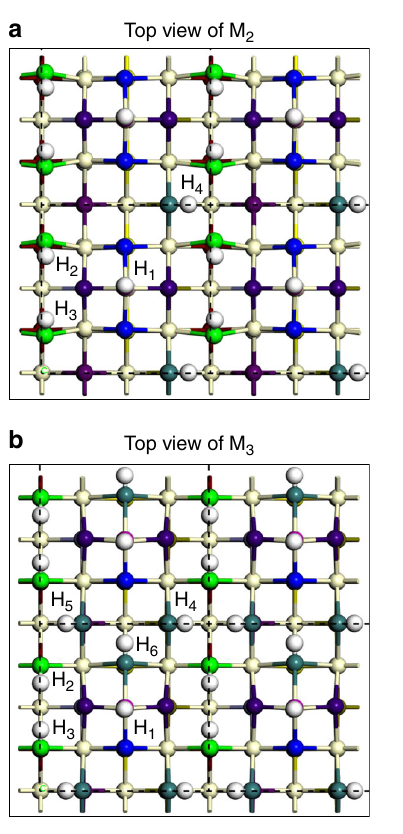
Fig. 6 Structure of M 2 and M 3 . White and off-white spheres represent hydrogen and cerium ions, respectively, in the top view of M 2 ( a ) and M 3 ( b ). Surface oxygen groups with different chemical shifts are in different colors. For each CeO 4 -t surface unit of M 2 , four hydrogen ions labeled as H 1 , H 2 , H 3 , and H 4 form from the two dissociative H 2 O molecules while for each CeO 4 -t surface unit of M 3 , six hydrogen ions labeled as H 1 , H 2 , H 3 , H 4 , H 5 , and H 6 form from the three dissociative H 2 O molecules.